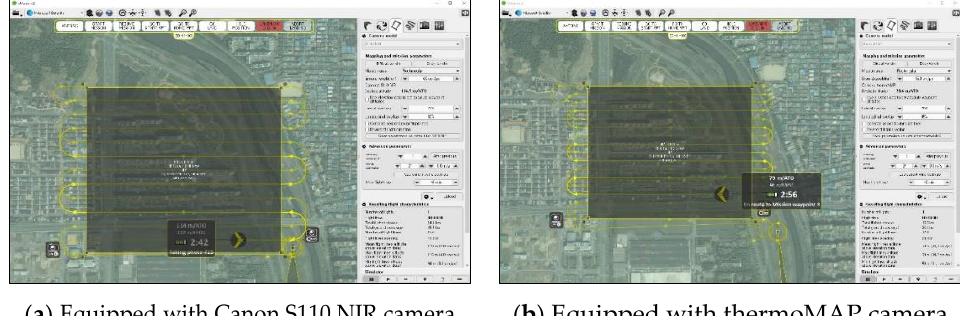
Figure 4. Set up of UAV flight planning using eMotion S/W.